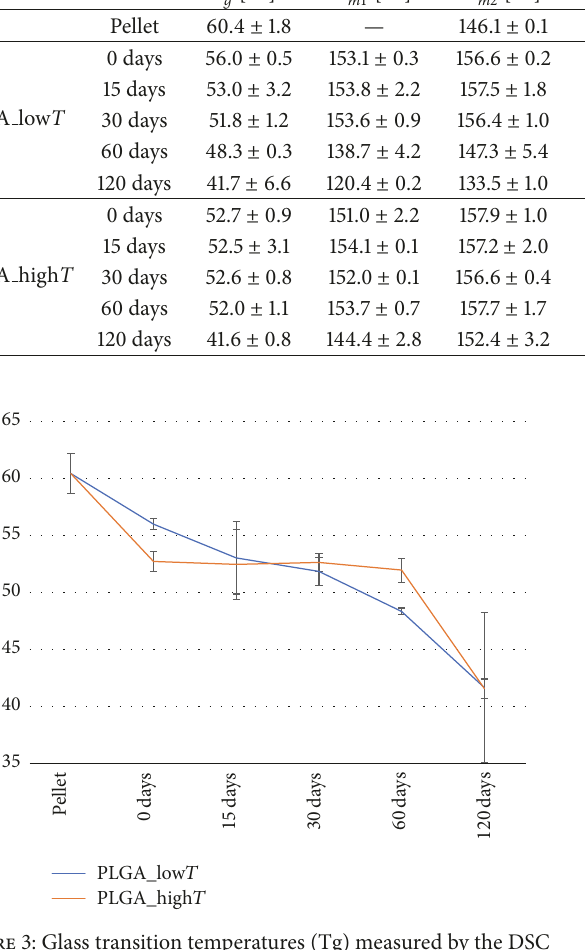
Figure 3: Glass transition temperatures (Tg) measured by the DSC for PLGA low T and PLGA high T .